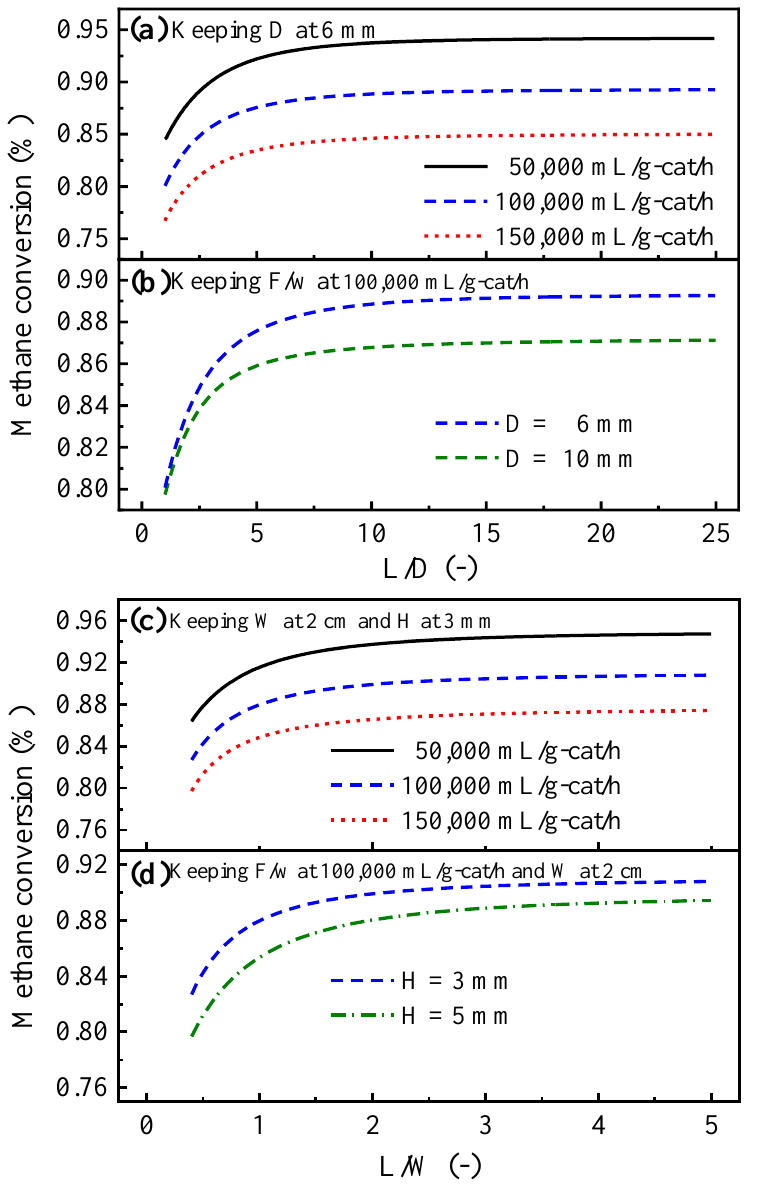
Figure 11. Methane conversion of different types of reformer channels with a different L/D (for tube-type) or L/W (for box-type) under different conditions ( a ): tube-type, D = 6 mm; ( b ): tube-type, F/w = 100,000 mL/g-cat/h; ( c ): box-type, H = 3 mm and W = 2 cm; ( d ): box-type, F/w = 100,000 mL/g-cat/h and W = 2 cm).